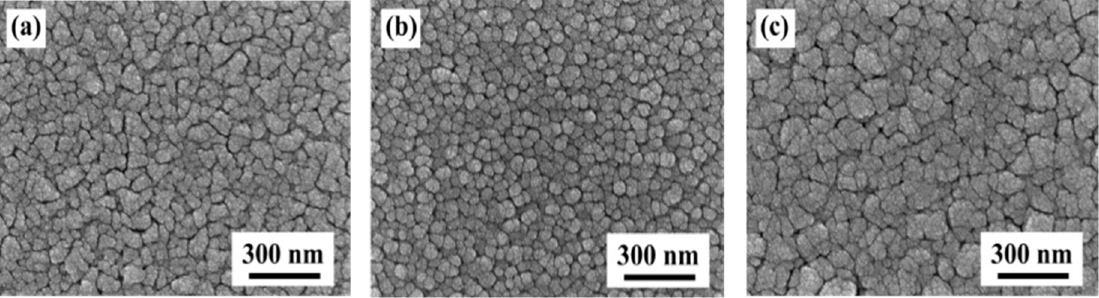
Figure 2. Surface scanning electron microscopy (SEM) images of the thin films: ( a ) ITO/Si; ( b ) IZO/Si; and ( c ) ITO/IZO/Si.